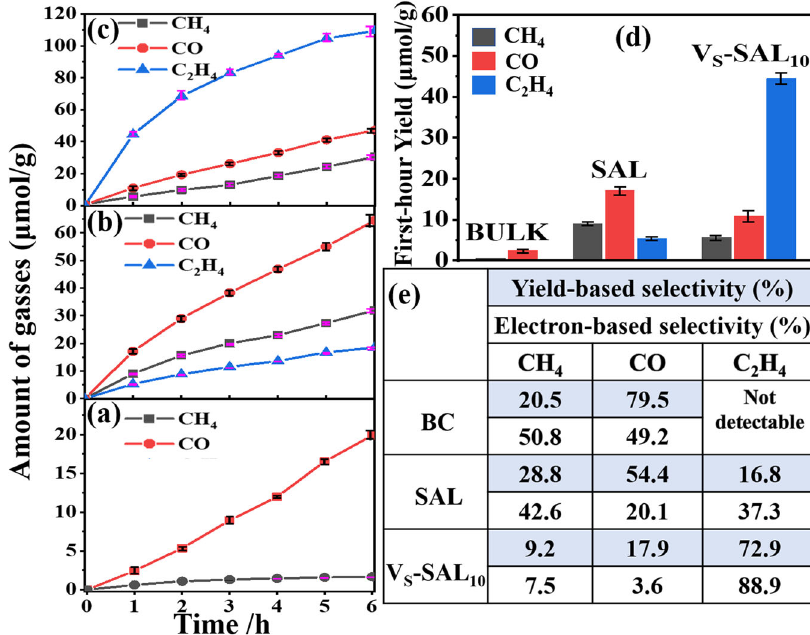
Fig. 3 Photocatalytic CO 2 reduction performance. Photocatalytic gases evolution amounts as a function of light irradiation times of a BC, b SAL, and c V S -SAL. d Photocatalytic activity for the fi rst hour. e Table illustration for the yield and electron-based selectivities of photocatalytic CO 2